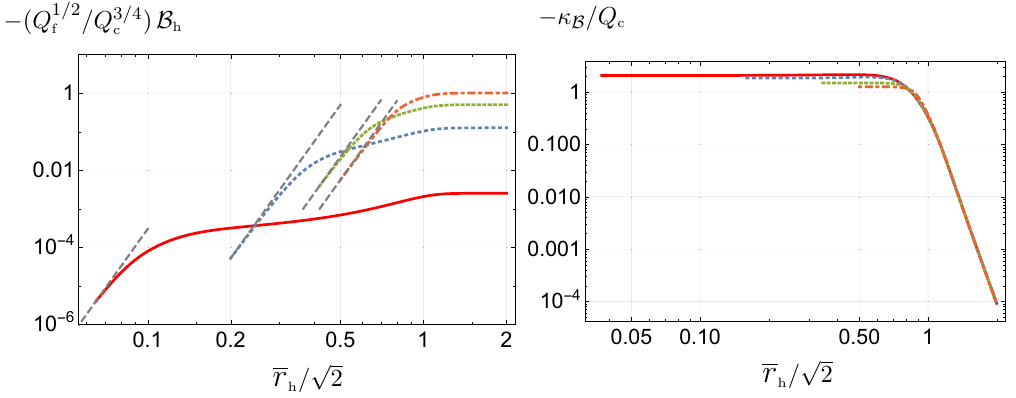
Figure 8 . IR and UV coefficients associated to the function legend in figure 4). The dotted gray lines show the behavior determined by the IR Lifshitz solution.